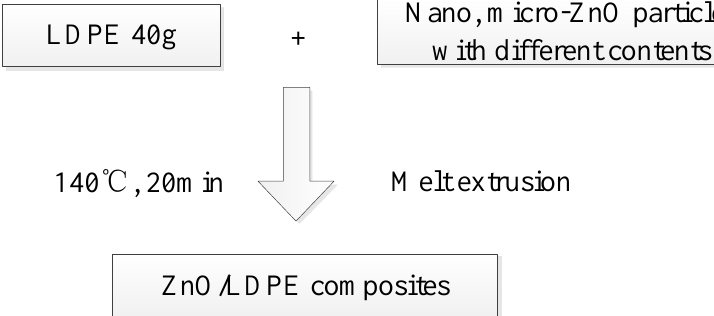
Figure 1. Preparation of micro and nanocomposites.